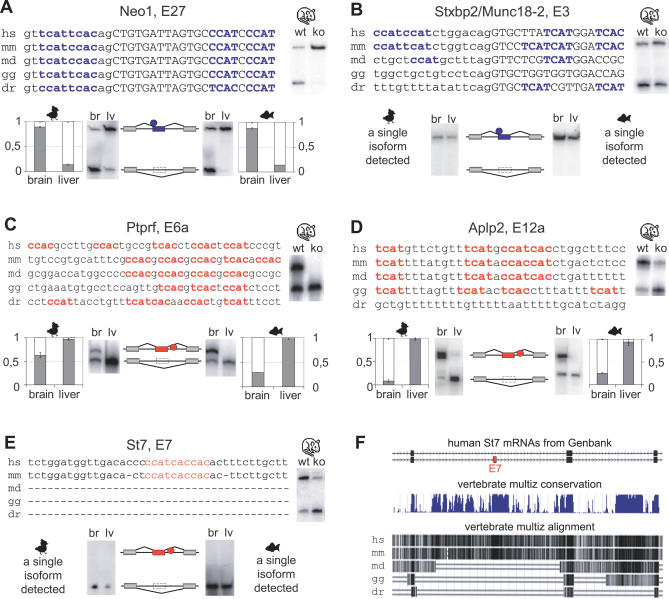
Five Examples of YCAY Cluster Conservation and RT-PCR Analysis of Associated ExonsMultiple nucleotide alignment of five YCAY clusters. Introns are in lowercase, exons in uppercase, YCAY silencer motifs in bold blue, and YCAY enhancer motifs in bold red. The abbreviations for the following species are used: H. sapiens (hs), M. musculus (mm), M. domestica (md), G. gallus (gg), and D. rerio (dr). Next to the alignment are RT-PCR data from wild-type and Nova2 knockout brain, and below are RT-PCR data from chicken and zebrafish brain and liver and diagrams of the splicing pattern. Blue represents silencing, red enhancement by Nova, rectangles represent exons, and circles represent the position of Nova binding.(A) Nova-dependent splicing silencer in neogenin (Neo1) pre-mRNA and brain-specific splicing of exon 27 conserved.(B) Nova-dependent splicing silencer in syntaxin binding protein 2 (Stxbp2/Munc18–2) pre-mRNA and brain-specific splicing of exon 3 are not conserved.(C) Nova-dependent splicing enhancer in protein tyrosine phosphatase, receptor type, F (Ptprf) pre-mRNA and brain-specific splicing of exon 6a are conserved.(D) Nova-dependent splicing enhancer is not conserved in zebrafish amyloid beta precursor-like protein 2 (Aplp2) pre-mRNA, in contrast with conserved brain-specific splicing of exon 12a.(E) Nova-dependent splicing enhancer in suppression of tumorigenicity 7 (St7) pre-mRNA and brain-specific splicing of exon 12a are not conserved.(F) The diagram obtained from the human genome browser shows the human St7 mRNAs that either contain or exclude the alternative exon 12a. Underneath, alignment of vertebrate genomes demonstrates lack of conservation in the region containing exon 12a in the genomes of oppossum, chicken, and zebrafish.